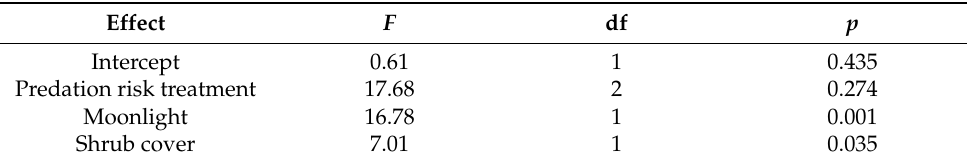
Figure 1. ( a ) Mean feeding time (s) ± SE, ( b ) mean fast locomotor activity (s) ± SE, and ( c ) mean slow locomotor activity (s) ± SE displayed by Abrothrix spp. depending on predation risk: G. nana calls (GN)/ S. rufipes calls (SR)/No vocalizations (NV). Number of events are in parenthesis. Table 2. Results of the GLM analyzing the effect of experimental and environmental factors on Abrothrix spp. fast locomotor activity.